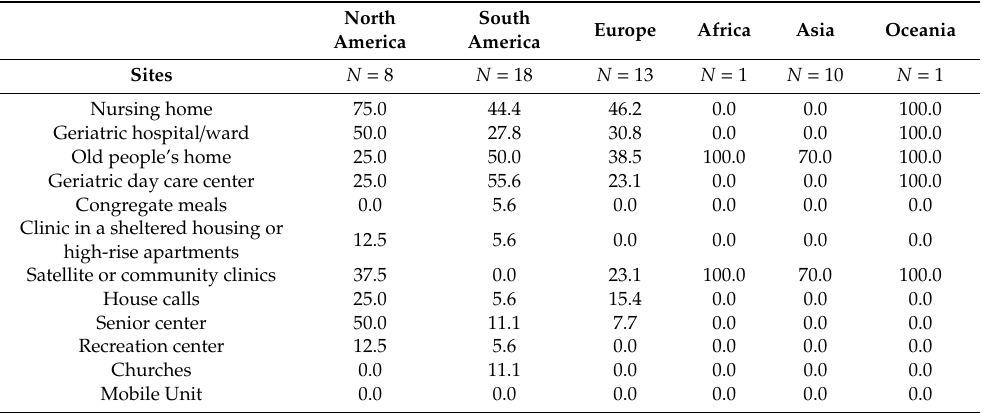
Table 6. Remote sites used for the clinical education of students in geriatric dentistry in undergraduate programs ( N =